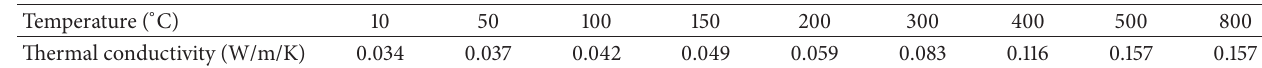
Figure 8: Inlet and outlet temperature variation of (a) core tank and (b) IHX. Table 1: Thermal conductivity of insulation